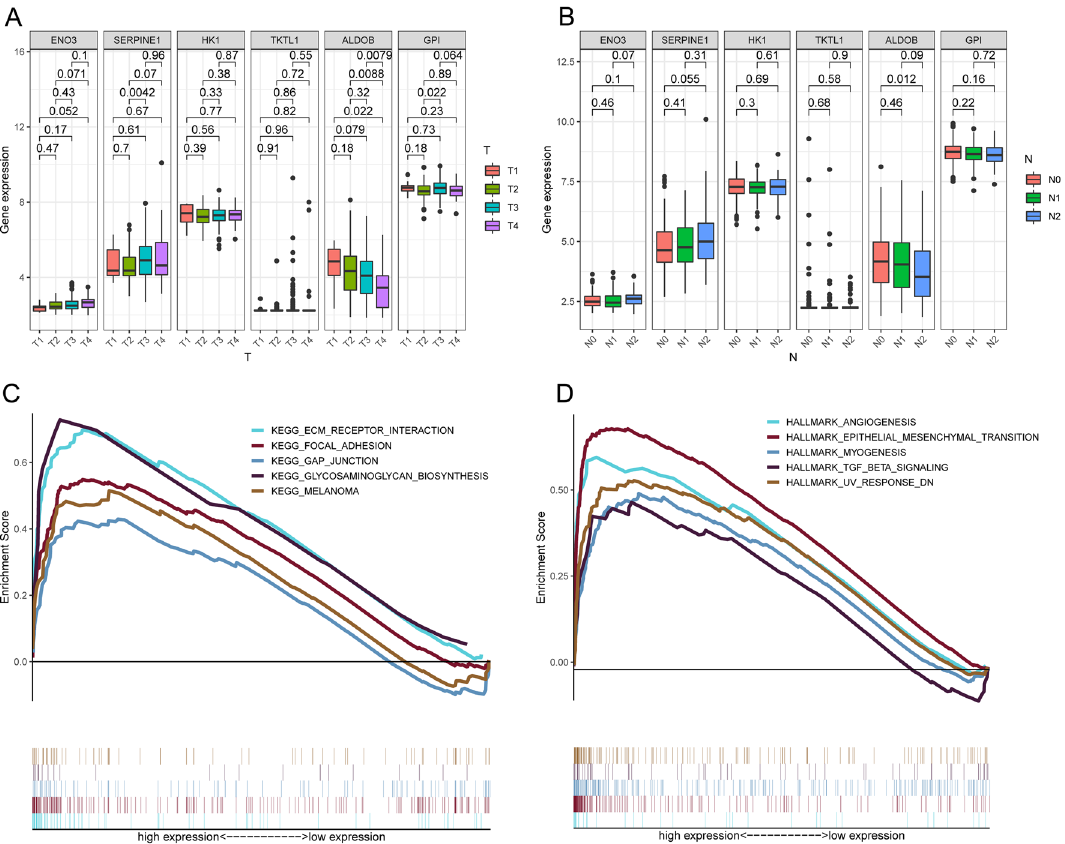
Figure 4. Function enrichment. Differential expression of the signature’s six HRGs in ( A ) T and ( B ) N stage tumors. ( C , D ) GSEA enrichment